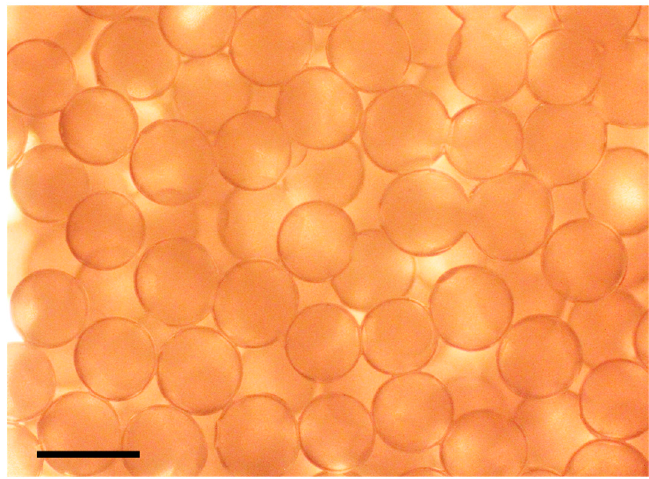
Figure 3. Micrograph of the produced gelatin microspheres using the co-flow microfluidic device. Scale bar, 400 μ m.